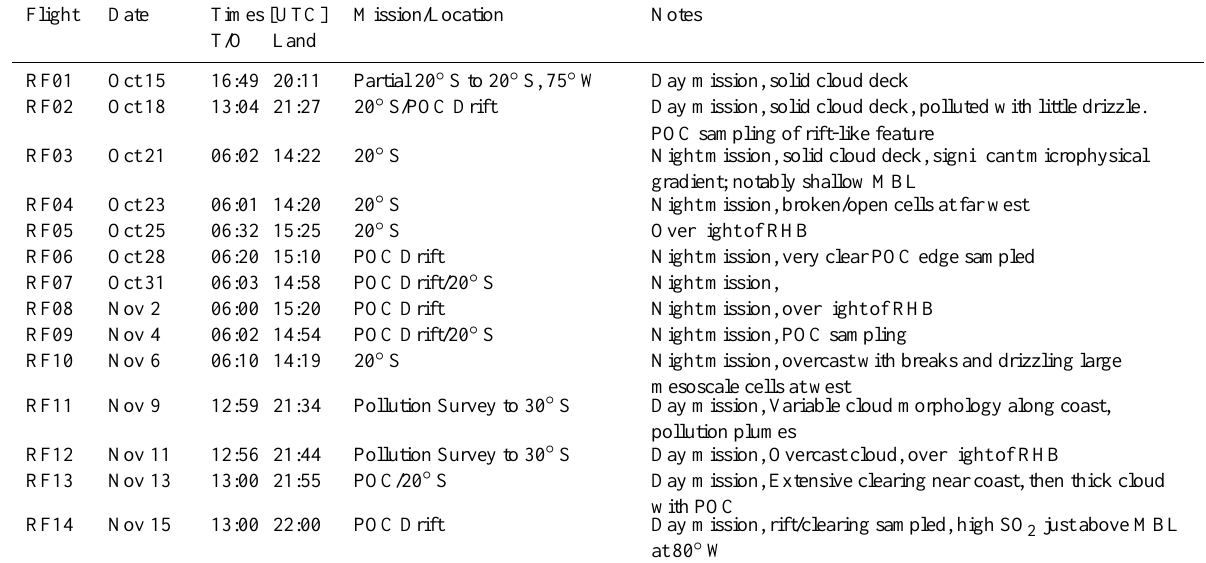
Table 6. Details of C-130 aircraft missions conducted in the VOCALS Regional